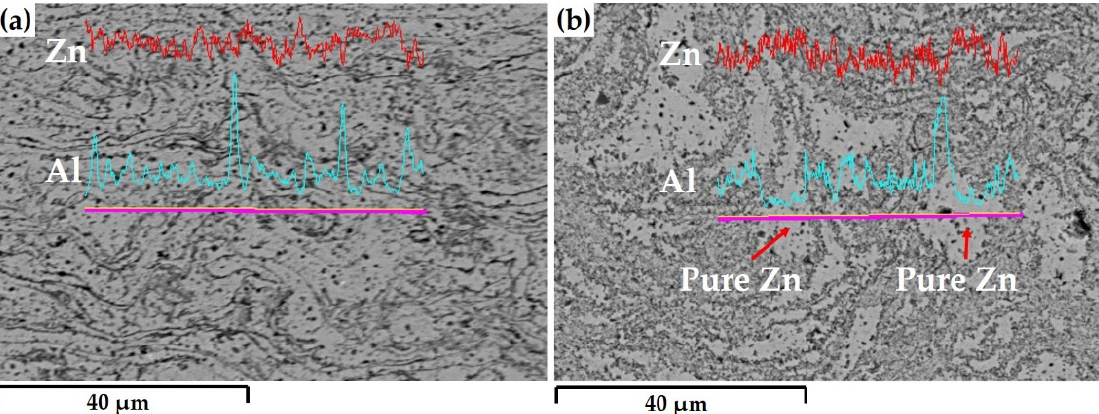
Figure 7. EDX line analyses of the coating microstructure; ( a ) compressed air sprayed coating and ( b ) argon sprayed coating.